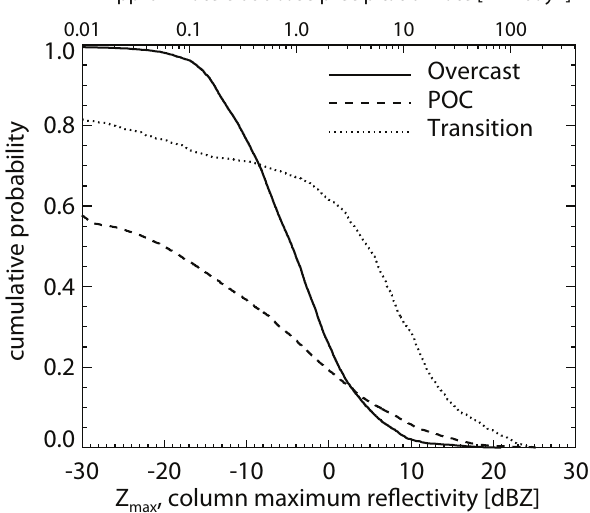
Fig.6. Cumulativeprobabilityofcolumnmaximumradarreflectivity Z max greaterthantheabscissalvalue,for Fig. 6. Cumulative probability of column maximum radar reflectiv- the overcast (solid), POC (dashed), and transition (dotted) regions. All available WCR data from all flight legs ity Z max greater than the abscissal value, for the overcast (solid), wereusedtoconstructtheplot. Thetopaxisdenotestheapproximatecloudbaseprecipitationratecorresponding POC (dashed), and transition (dotted) regions. All available WCR to Z max constructed using the Z – R relationship discussed in Sect. 2.3. data from all flight legs were used to construct the plot. The top axis denotes the approximate cloudbase precipitation rate correspond- ing to Z max constructed using the Z - R relationship discussed in Sect.